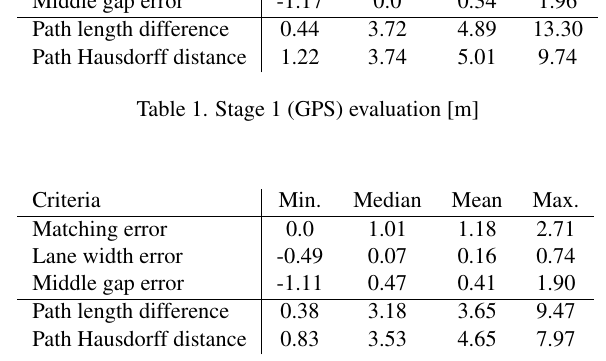
Table 1. The evaluations of the second dataset, comprising GPS, IMU and DMI, are shown in Table 2.